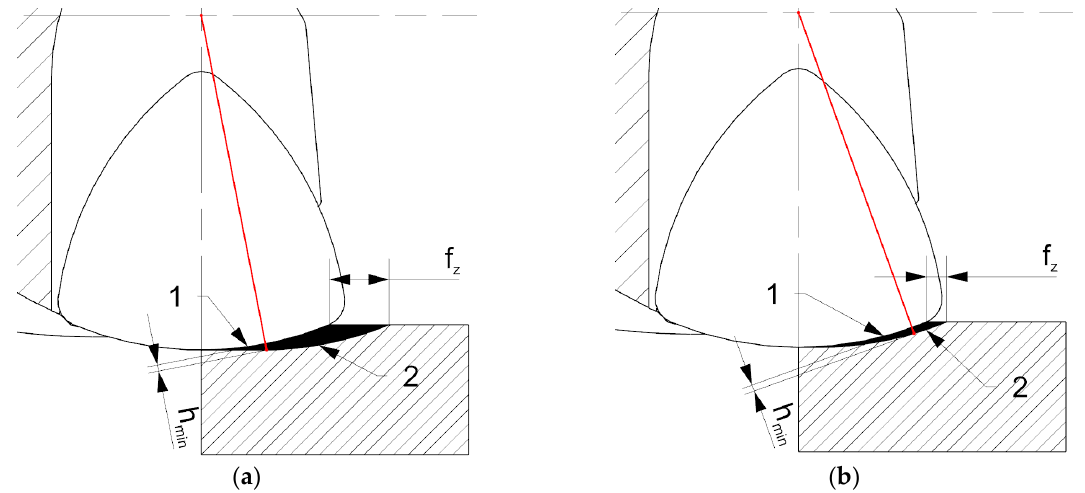
Figure 14. The influence of feed rate on cutting zones in HF milling: ( a ) high feed rate, ( b ) low feed rate. 1—elastic-plastic zone, 2—cutting zone (decohesion of the material).